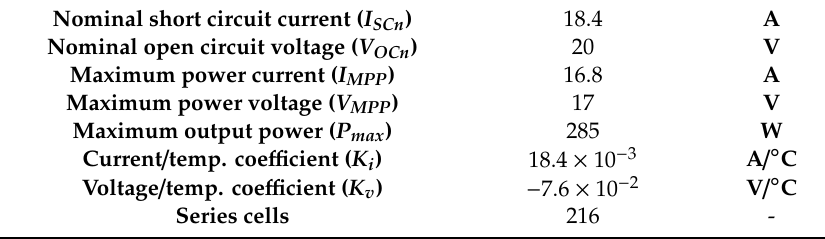
Figure 1. PV-grid connected system under investigation. ( a ) System topology, ( b ) modified sinusoidal pulse width modulation (SPWM) gating signals, ( c ) grid connected current source inverter (CSI) equivalent circuit. Table 1. PV panel (ASE-285-DGF / 17) parameters used in simulation